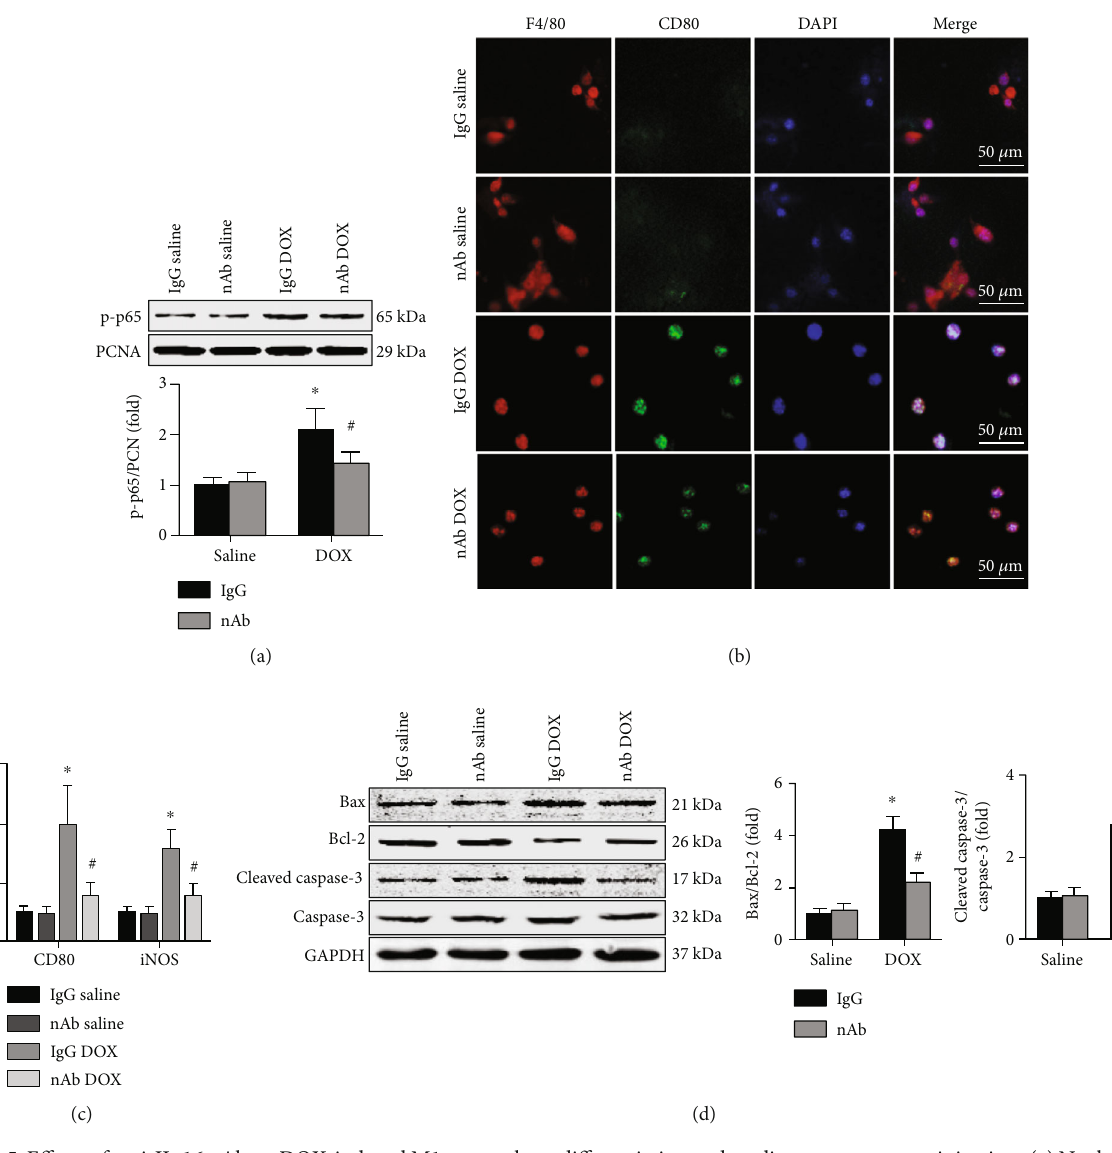
Figure 5: E ff ects of anti-IL-16 nAb on DOX-induced M1 macrophage di ff erentiation and cardiomyocyte apoptosis in vitro. (a) Nuclear p-p65 expression in RAW264.7 macrophages was detected (ANOVA). (b) Double immuno fl uorescence staining of anti-F4/80 and anti-IL-16 in DOX-treated mice (200x, nonparametric test). (c) The mRNA expression of CD80 and iNOS was detected (ANOVA). (d) Protein expression of Bax, Bcl-2, cleaved caspase-3, and caspase-3 was measured and the ratios of Bax/Bcl-2 and cleaved caspase-3/caspase-3 (ANOVA). N = 5 for each group. ∗ p < 0 : 05 vs. the IgG saline group. # p < 0 : 05 vs. the IgG DOX